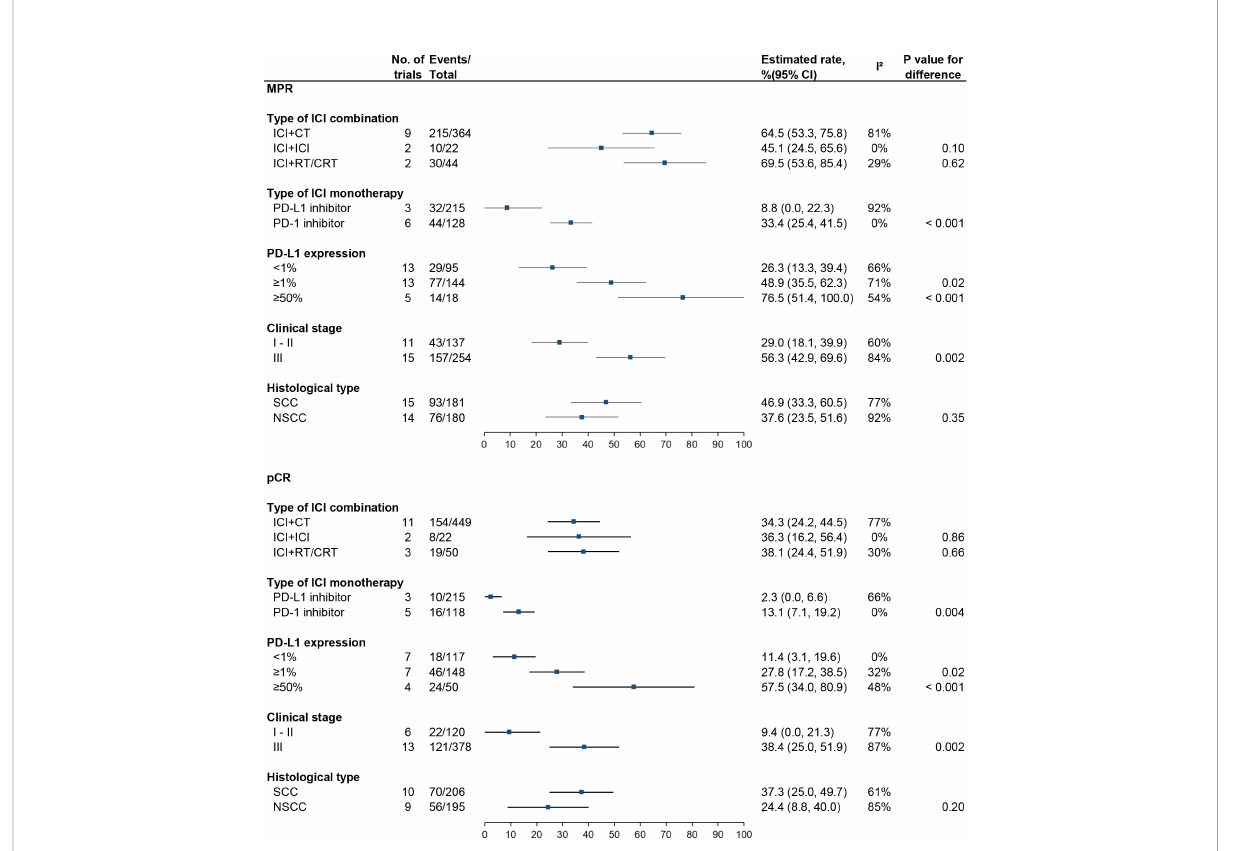
FIGURE 3 Subgroup analyses for MPR and pCR in patients receiving neoadjuvant ICI. MPR, major pathologic response; pCR, pathological complete response; ICI, checkpoint inhibitor; CT, chemotherapy; RT; radiotherapy; CRT; chemoradiotherapy; SCC, squamous cell carcinoma; NSCC, non- squamous cell